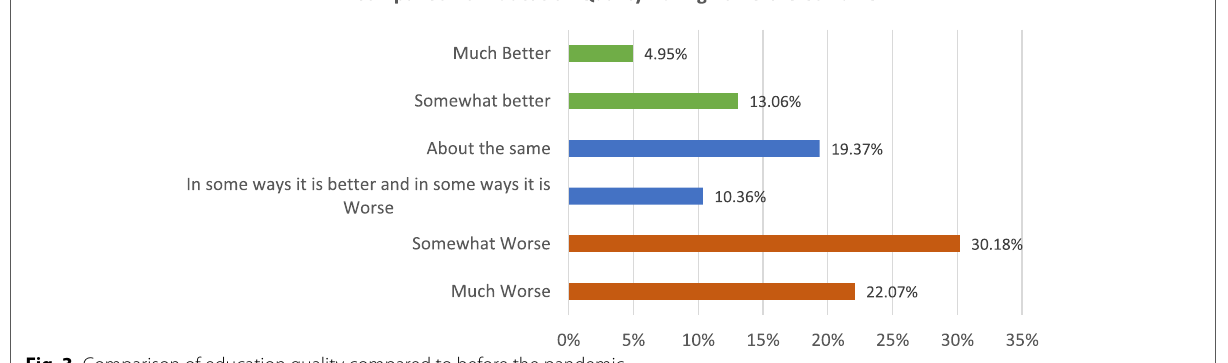
Fig. 3 Comparison of education quality compared to before the pandemic